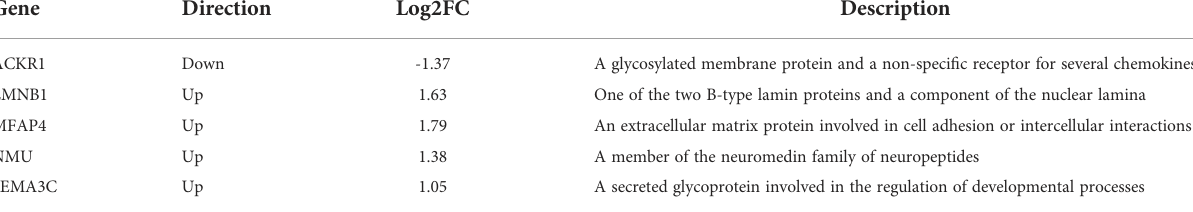
TABLE 2 Diagnostic marker genes and expression information obtained by machine learning algorithm.